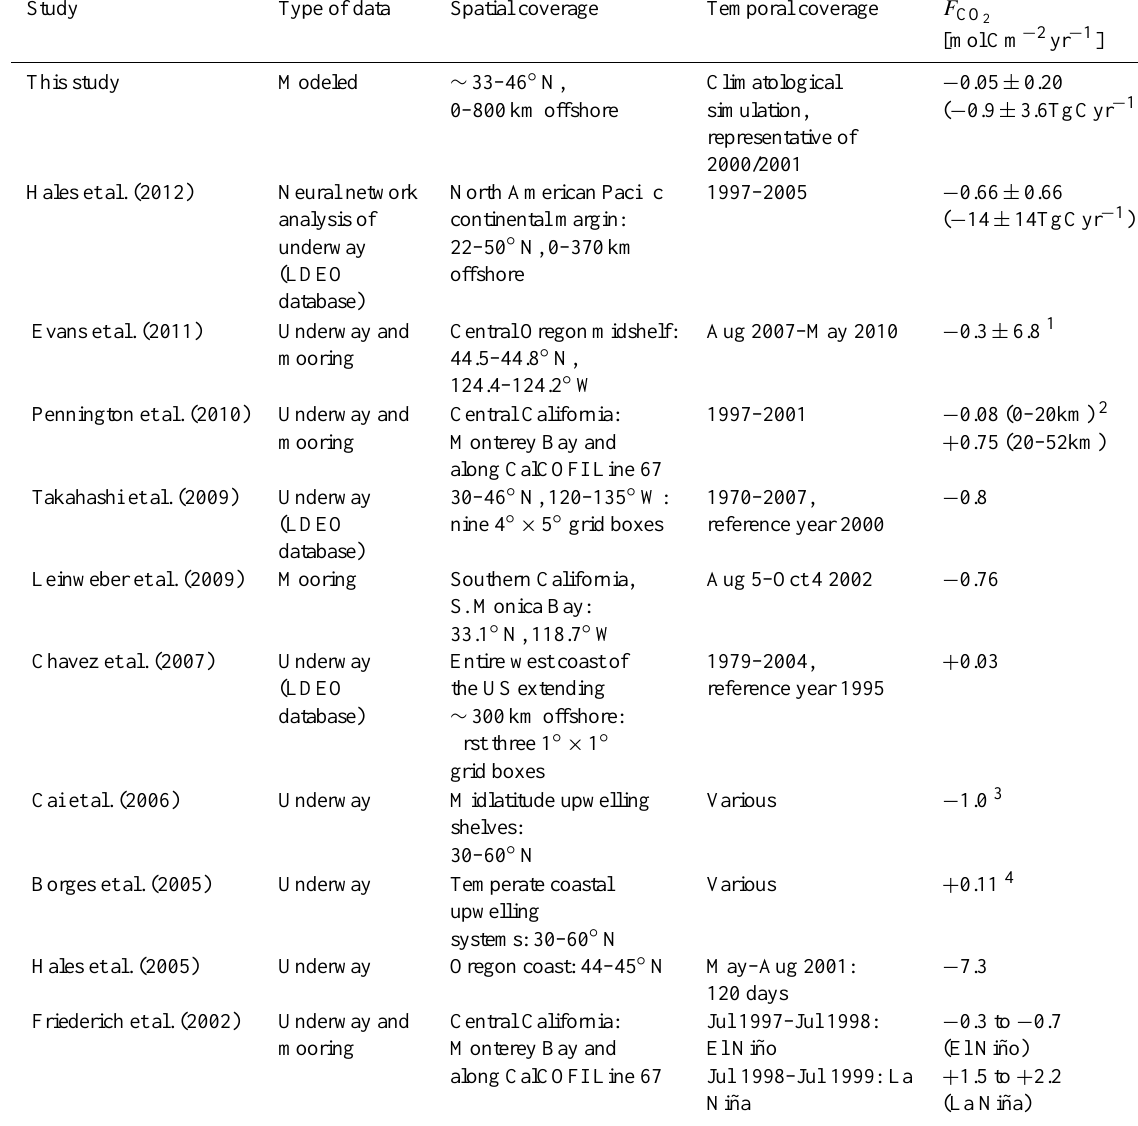
values indicate a source to the atmosphere, while negative values mean an uptake by the surface 2